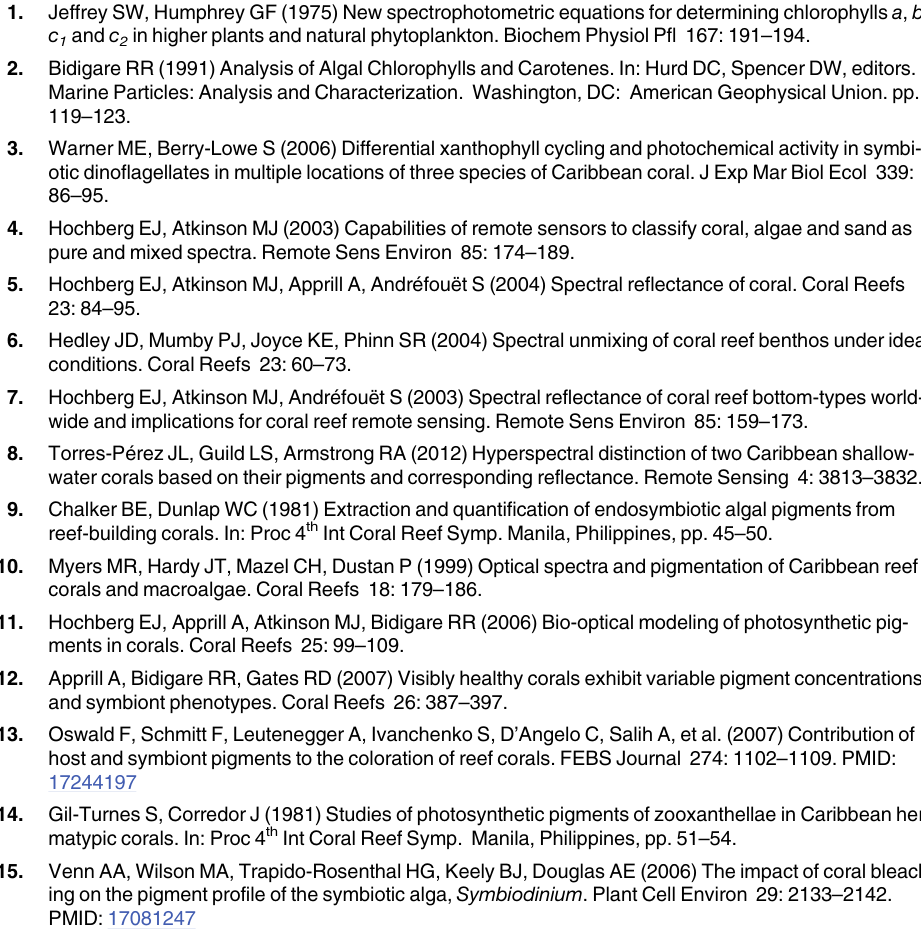
S1 Table. Percent of colonies from each species containing a particular